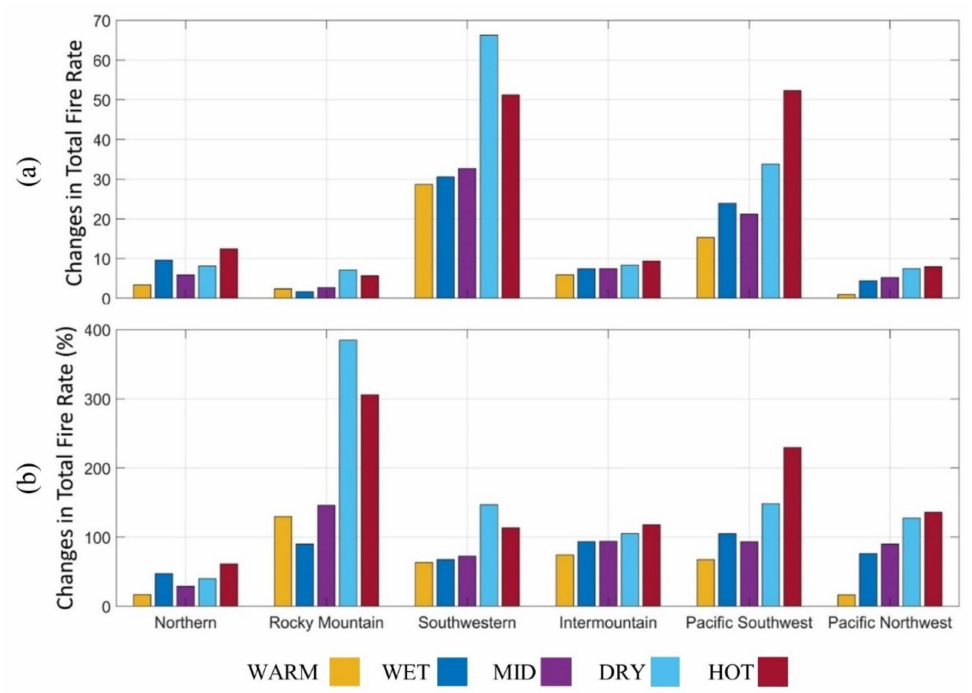
Figure 8. ( a ) Absolute changes in total fire rate and ( b ) percentage changes on total fire rate of United States Forest Service regions from historical (1986–2015) to future conditions